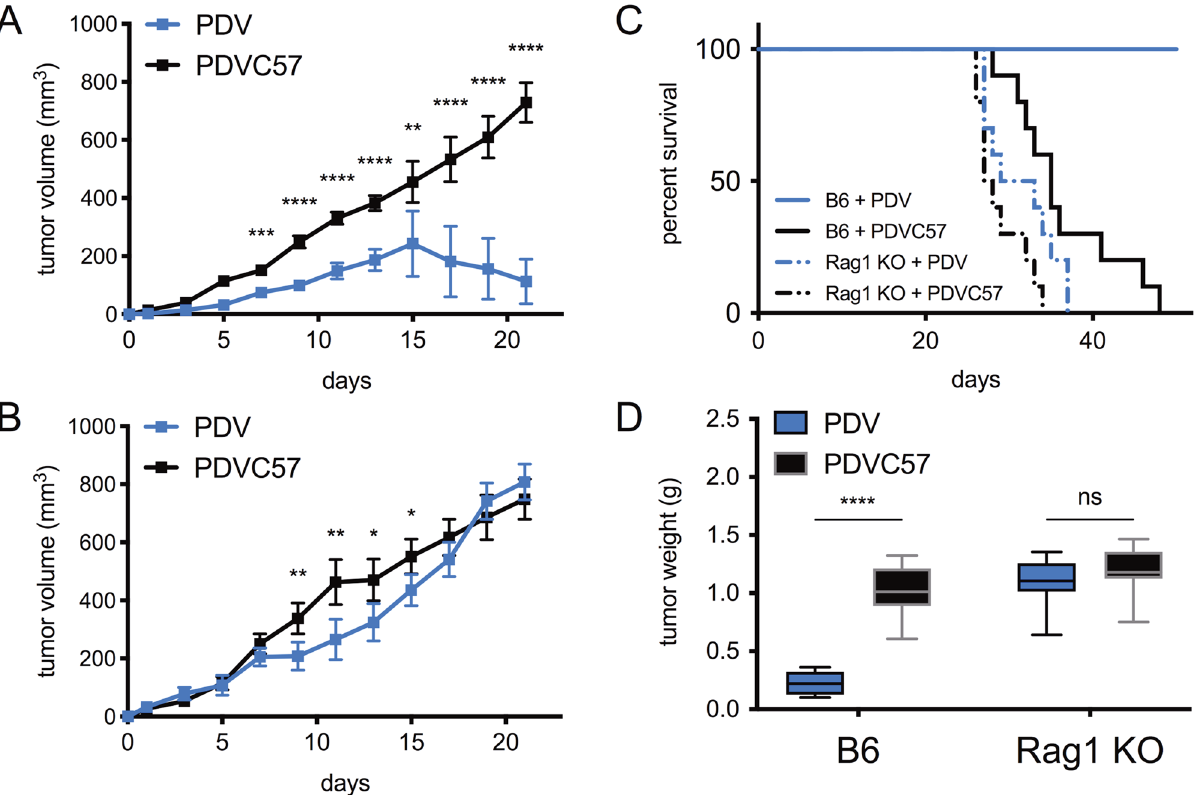
Figure 3. PDVC57 tumors grow in immunocompetent mice, unlike PDV tumors. ( A ) PDV tumors regress at approximately two weeks in immunocompetent B6 mice while PDVC57 continue to grow. ( B ) Both PDV and PDVC57 tumors continue to grow without regression in immunodeficient Rag1 KO mice. ( C ) Kaplan–Meier survival curves of PDV and PDVC57 in either B6 or Rag1 KO mice. Mantel-Cox test demonstrated significantly different survival curves, P < 0.0001. Post-hoc analysis demonstrates that in B6 mice, there exists a significant difference between PDV and PDVC57 tumors ( P < 0.0001), while in Rag1 KO mice, there is no significant difference between PDV and PDVC57 tumors. ( D ) Endpoint tumor weights of PDV and PDVC57 in either B6 or Rag1 KO mice. * P < 0.05; ** P < 0.01; *** P < 0.001; **** P < 0.0001 in ( A ), ( B ), and ( D ) using the unpaired t -test adjusted for multiple comparisons. Two separate experiments with n > 10 per